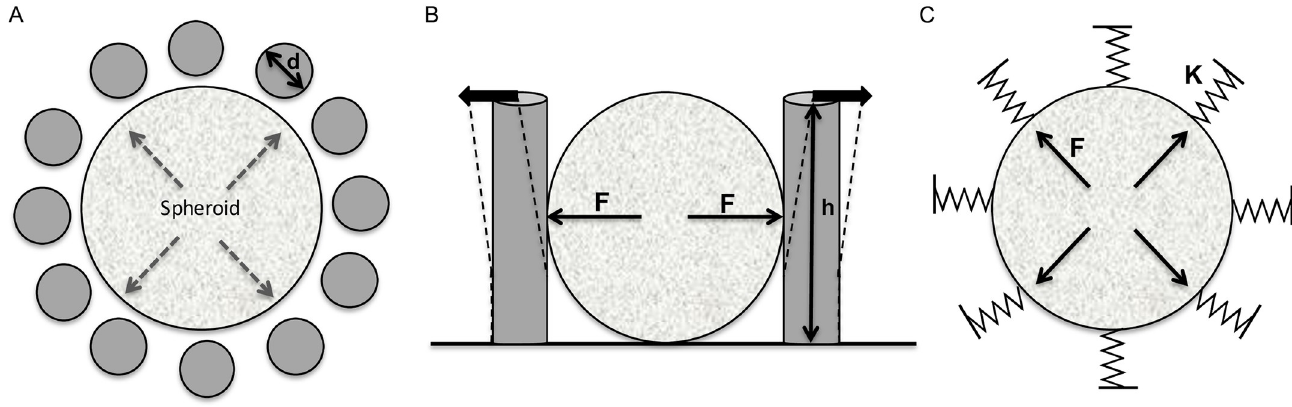
Fig 1. High aspect ratio microdevices for the measurements of forces exerted by growing spheroids. (A) Plane view of the circular arrangement of the PDMS pillars surrounding a spheroid. (B) Lateral view of the pillar displacement induced by a growing spheroid. (C) Forces (F) generated by the growing spheroid on the surrounding environment induce an outward displacement of the pillars. Pillars are defined by their diameter (d), height (h), and spring constant